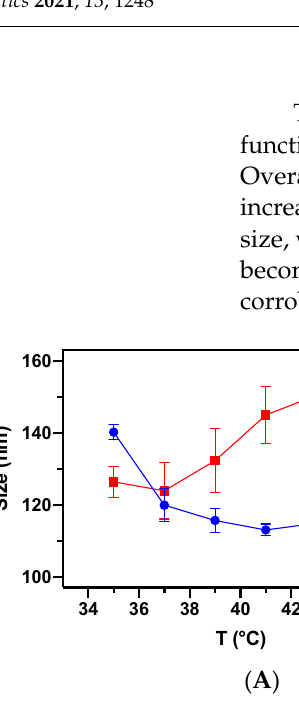
( B ) Figure 14. In vitro kinetic release profile of doxorubicin encapsulated in SMLs at different conditions of temperatures and pH, with the triplicate mean fitted to the Weibull kinetic model. ( A ) DPPC SMLs; ( B ) DPPC:DSPE-PEG SMLs. Similarly to the Weibull model, the first-order model revealed a higher R 2 for the assays performed at 42 °C and pH = 5.5 in both formulations, suggesting that the amount of released DOX is proportional to the remaining drug in the nanocarrier. The Korsmeyer– Peppas model presents the worst coefficient of determination values. The n values are